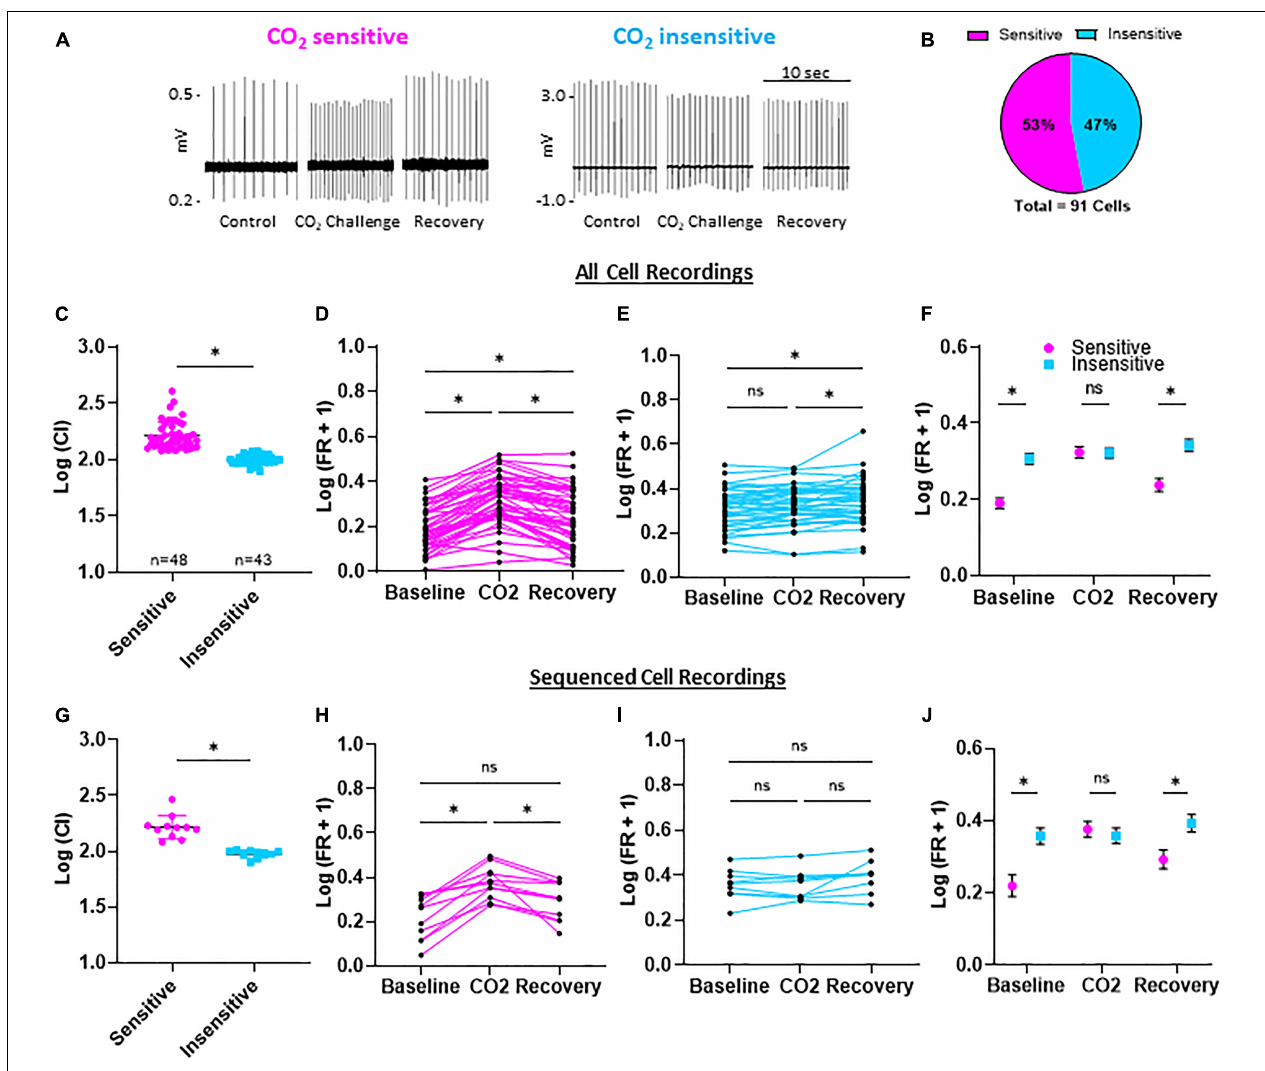
FIGURE 2 | Firing rates and chemosensitivity index (C.I.) of CO 2 sensitive and insensitive 5-HT neurons. Representative, condensed recording traces during control (95% O 2 /5% CO 2 ; 7.363 pH), CO 2 challenge (85% O 2 /15% CO 2 ; 7.092 pH), and recovery (95% O 2 /5% CO 2 ; 7.363 pH) (A) . Distribution of CO 2 sensitive or insensitive 5-HT neurons among 91 neurons (B) . Log transformed chemosensitivity index (C.I.) of CO 2 sensitive and insensitive 5-HT neurons (C) . Log transformed firing rates during baseline, CO 2 challenge, and recovery compared among all CO 2 sensitive (D) , CO 2 insensitive (E) , and between CO 2 sensitive and insensitive (F) 5-HT neurons. The sub-population of neurons used for scRNA-Seq had representative log transformed C.I. values, and firing rate differences during baseline, CO 2 challenges, and recovery (G–J) . Notably, baseline and recovery firing rates were lower in CO 2 sensitive vs. insensitive 5-HT neurons while firing rate during the CO 2 challenge was similar between CO 2 sensitive and insensitive neurons. Unpaired, two-tailed student’s t -test (C,G) . One-way repeated measures ANOVA with Sidak’s multiple comparisons test (D,E,H,I) . ANOVA results: Condition p < 0.0001 and Individual Cell p < 0.001 (D) ; Condition and Individual Cell p < 0.0001 (E) ; Condition p = 0.0002 and Individual Cell p = 0.0025 (H) ; Condition p = 0.0539 and Individual Cell p < 0.0001 (I) . Two-way repeated measures ANOVA with Sidak’s multiple comparisons test (F,J) . Condition p < 0.0001, Cell Phenotype p = 0.0005, and Interaction p < 0.0001 (F) ; Condition p = 0.0002, Cell Phenotype p = 0.0279, and Interaction p < 0.0001 (J) . ∗ p < 0.05 and ns, not